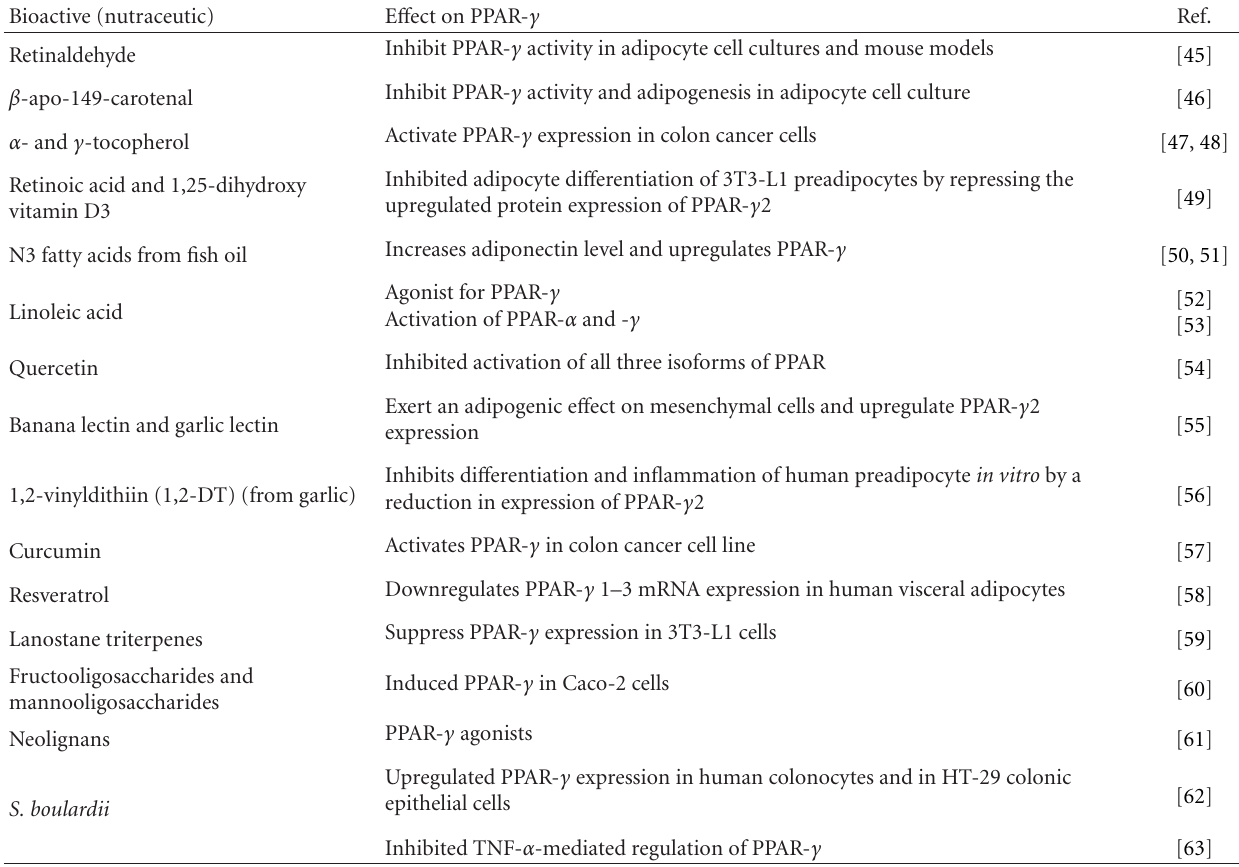
Table 2: Modulation of PPAR- γ by